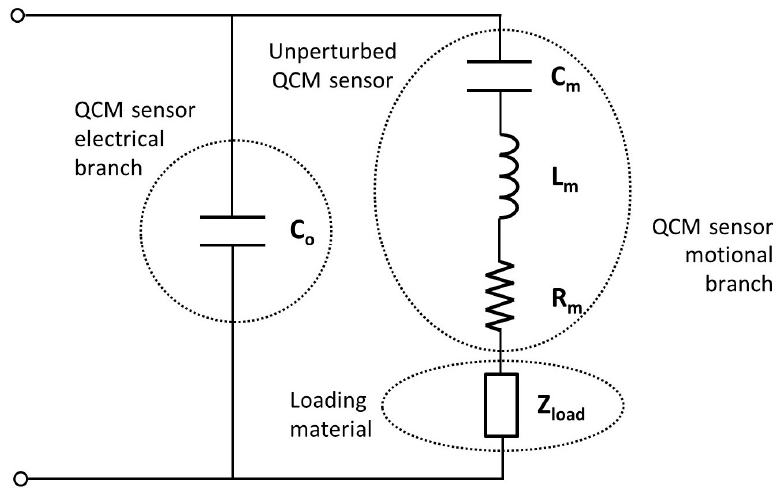
Figure 1. Equivalent electrical model of the QCM sensor.